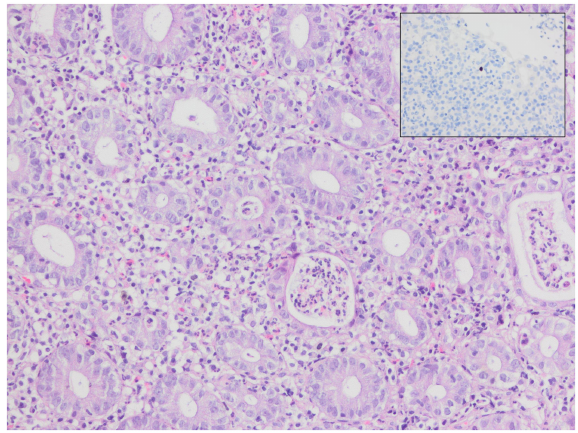
Figure 1. In sections, colon mucosa with ulcerated surface is observed. Active chronic inflammation rich in neutrophils and cryptic abscesses was detected in the lamina propria. Inset shows a small number of immunohistochemical CMV